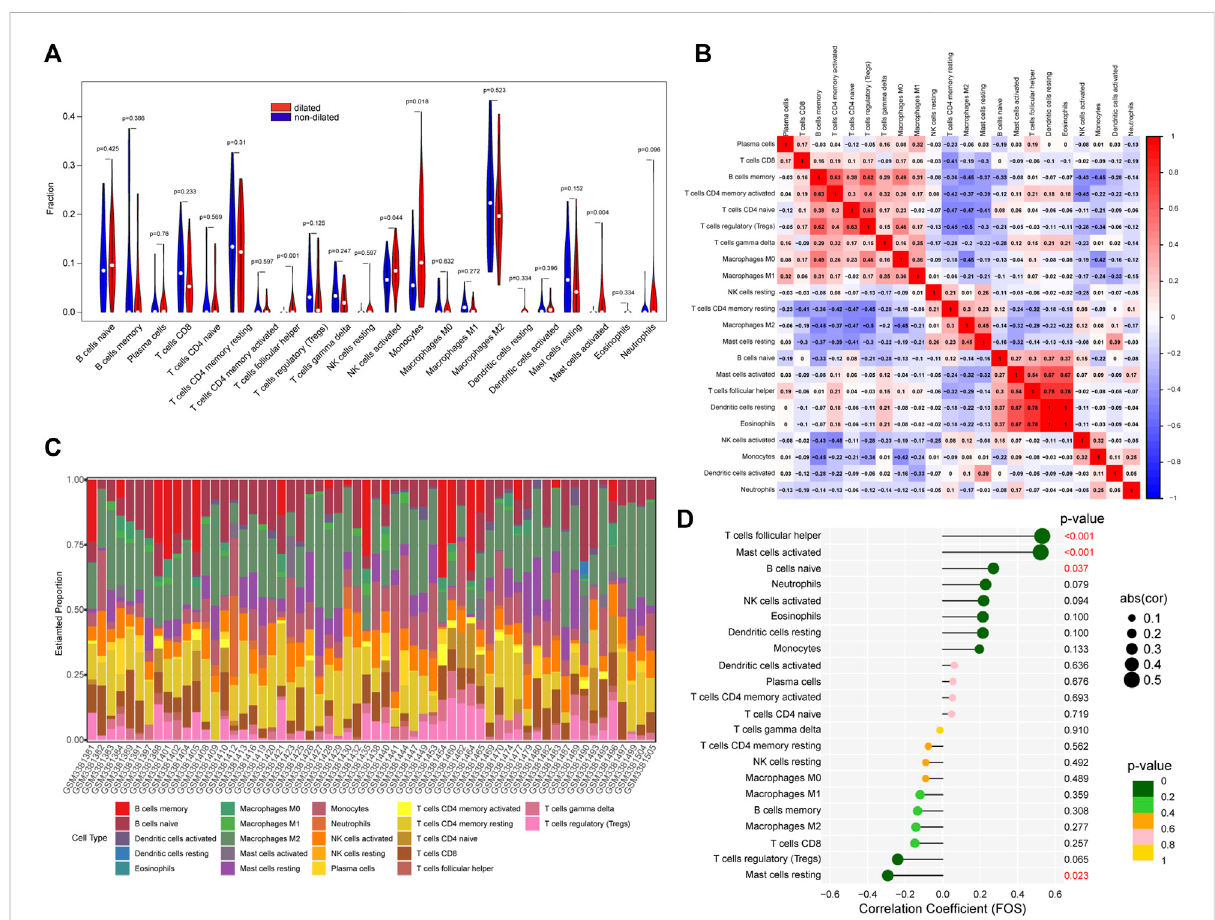
The immune cells in fi ltration between dilated and non-dilated groups. (A) The difference between dilated and non-dilated PVAT groups. Red arearepresentsdilatedgroupandbluearearepresentsnon-dilatedgroup. p < 0.05wasconsideredassigni fi cant. (B) Correlationheatmapofimmune cells. Red represents positive correlation and blue represents negative correlation. (C) The percentage of each immune cell in each sample. (D) The correlation between FOS and immune